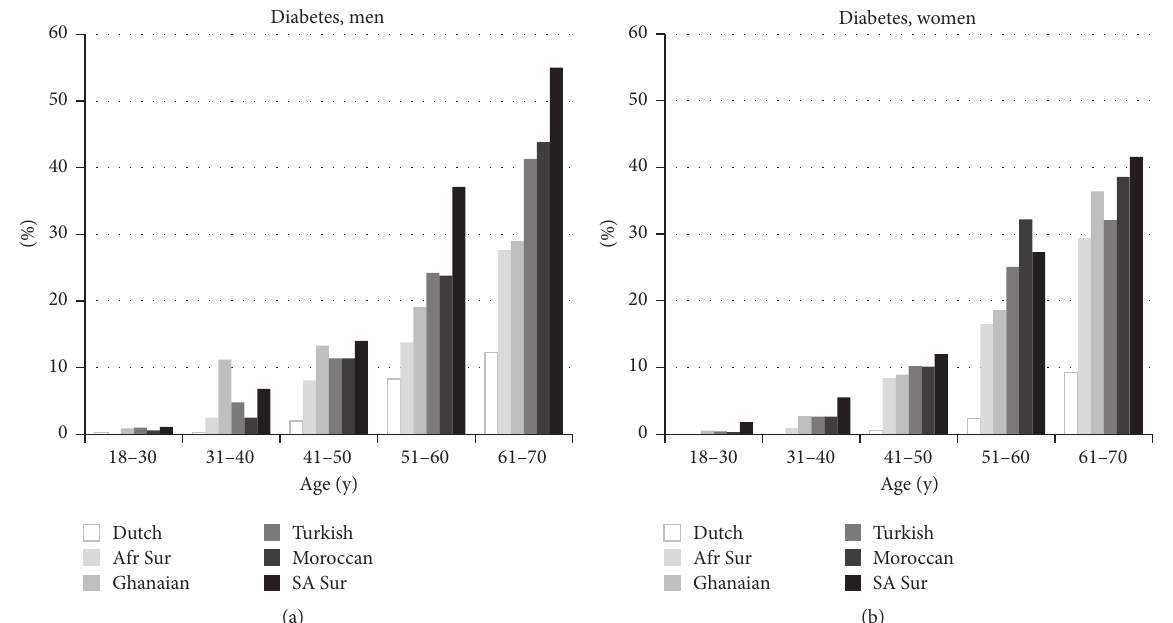
Figure2:(a)Theprevalenceofdiabetesbyethnicity,sex,andagegroups(men).AfrSur,AfricanSurinamese;SASur,South-AsianSurinamese. (b) The prevalence of diabetes by ethnicity, sex, and age groups (women). Afr Sur, African Surinamese; SA Sur, South-Asian Surinamese.